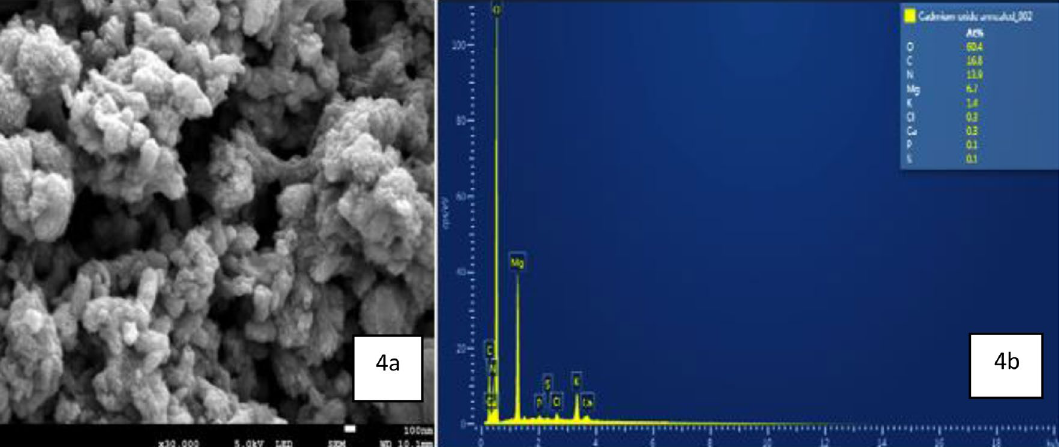
Figure 4. ( a ) SEM image of powder containing CdO/CdCO 3 showing agglomeration and the presence of spherical structures, ( b ) SEM EDX spectrum showing different elements.